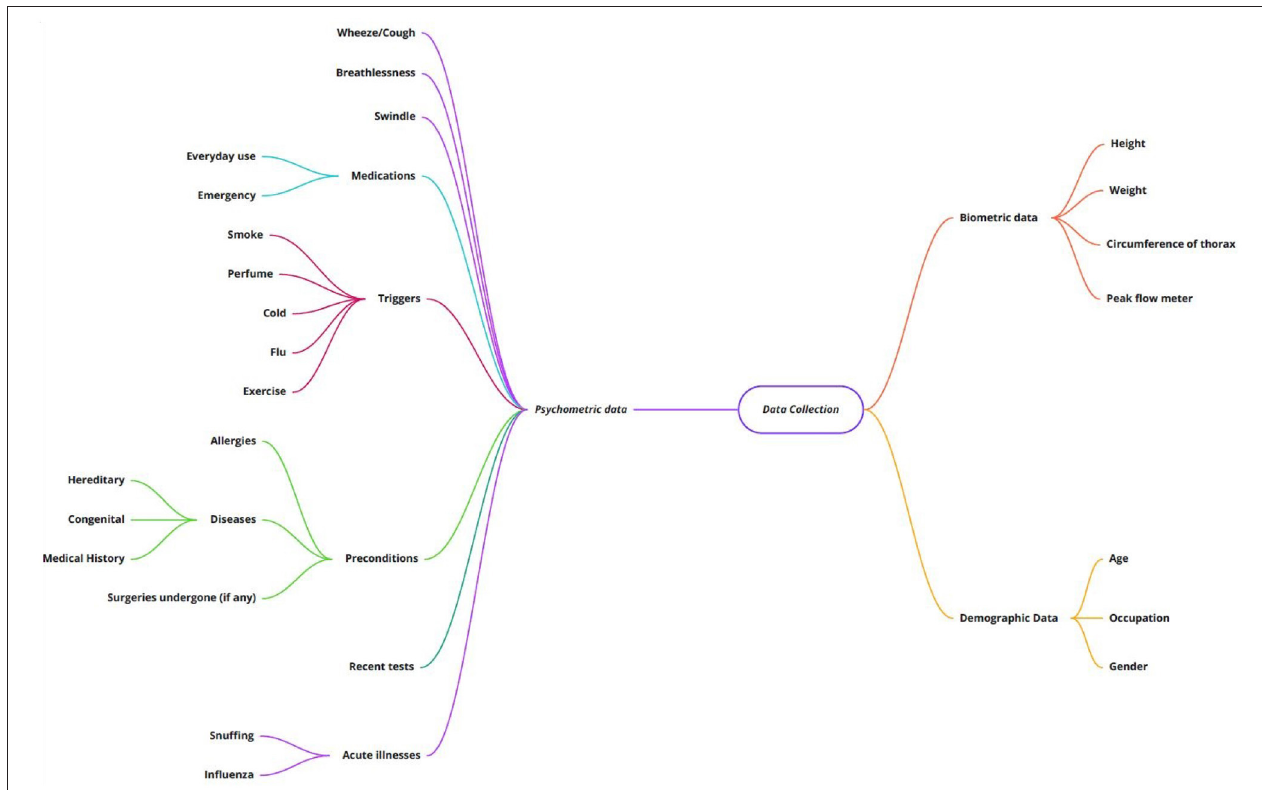
FIGURE 2 | Complete overview of data to be collected.